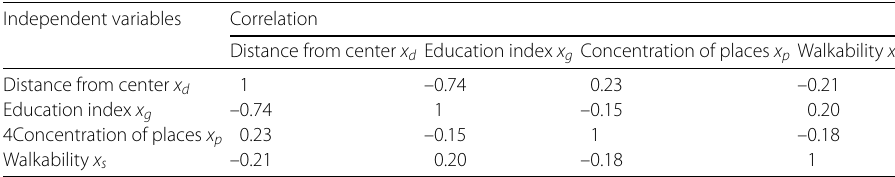
Table 1 Correlation between the independent variables Independent variables